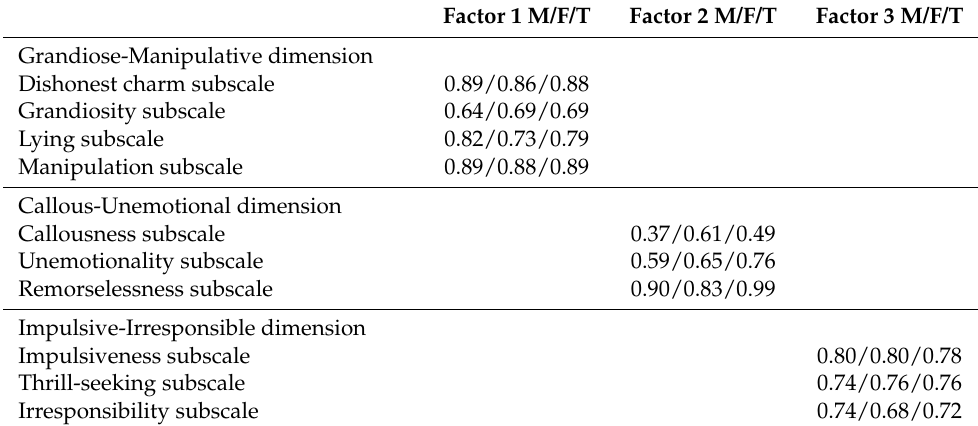
Table 1. Loadings for the confirmatory three-factor inter-correlated robust structure of the YPI.